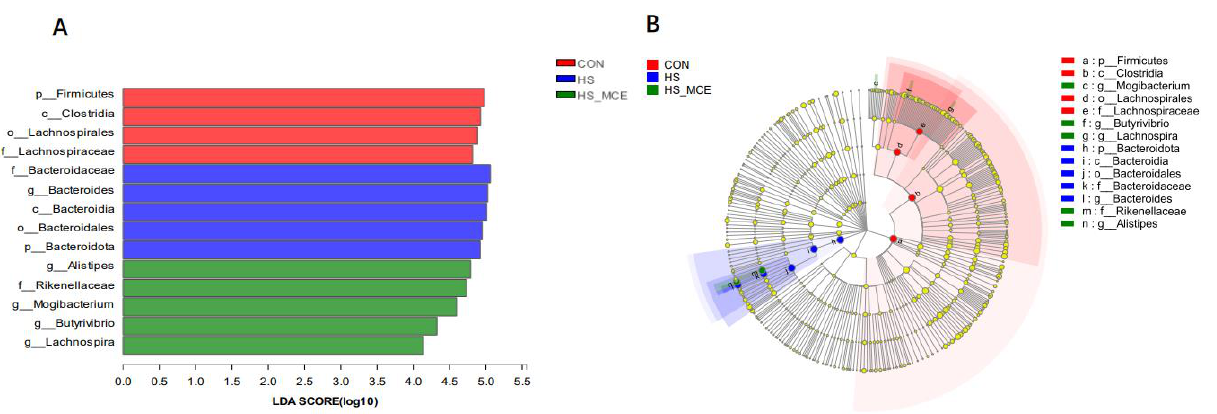
Figure 2. Linear discriminant analysis (LDA) effect size (LEfSe) analysis ( p < 0.05, LDA > 4.0) of the intestinal microbes. ( A ) LDA. ( B ) LEfSe. The prefixes “p”, “c”, “o”, “f”, and “g” represent the annotated level of phylum, class, order, family, and genus. Abbreviations: CON, control group; HS, heat stress group; HS-MCE, Heat Stress plus MCE group.